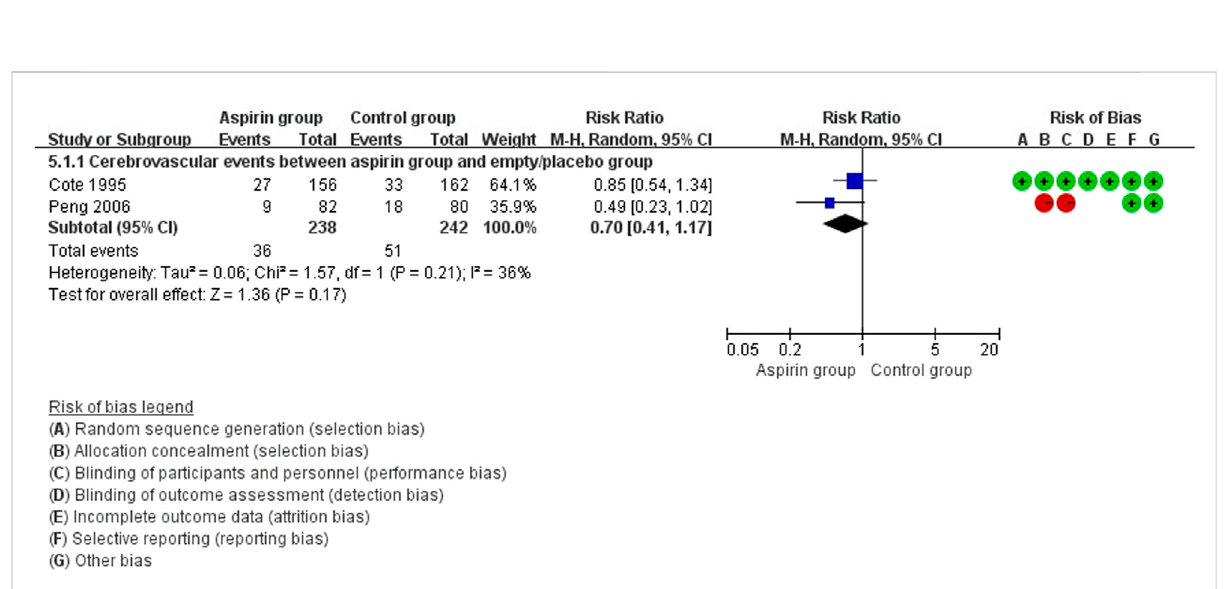
FIGURE 5 Forest plot of cerebrovascular events between the aspirin group and the control